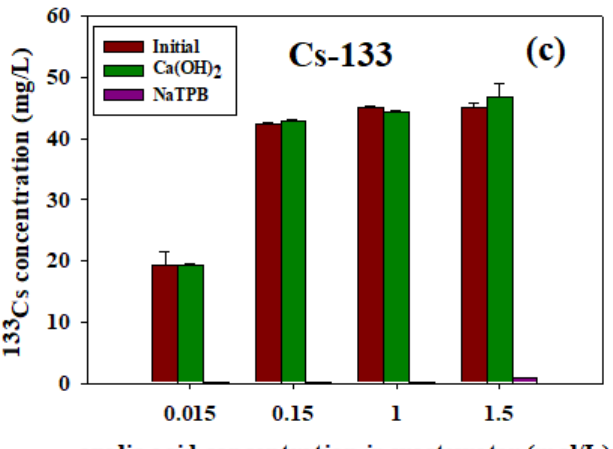
Figure 8. After the desorption experiment with oxalic acid at various concentrations: ( a ) the initial concentration of metal ions in the washing wastewater, ( b ) the concentration of cations after Ca(OH) 2 0.025 g/mL treatment, and ( c ) the concentration of 133 Cs after 0.025 g/mL Ca(OH) 2 and 2 mg/mL NaTPB treatment. (n = 2, mean ± standard error of mean).